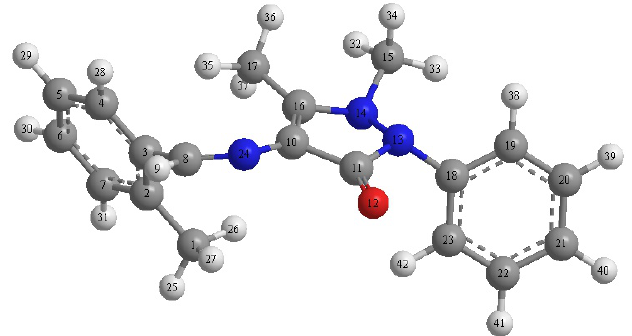
Figure 4. The 3D-structure of synthesized compound DMPO .